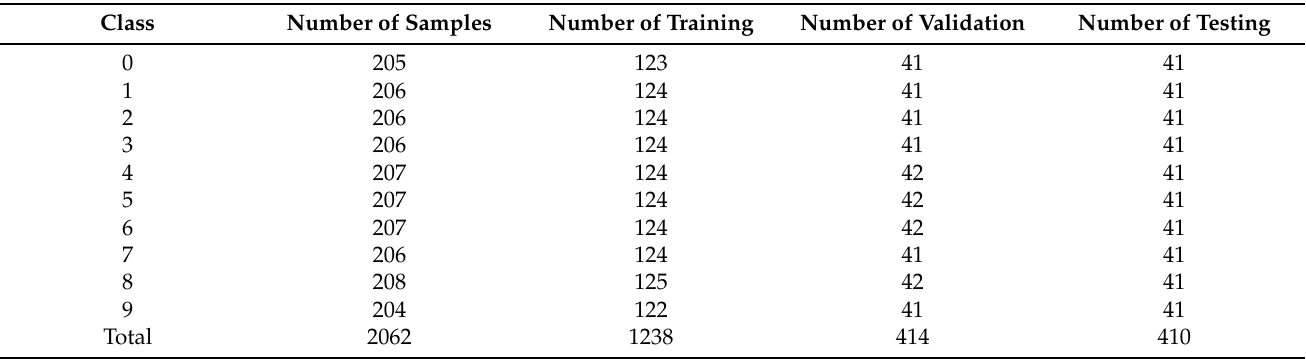
Figure 1. Sample images of the dataset [36]. The number below each image represents the de- coded sign. Table 1. Dataset [36] details. Example Images in the dataset are given in Figure